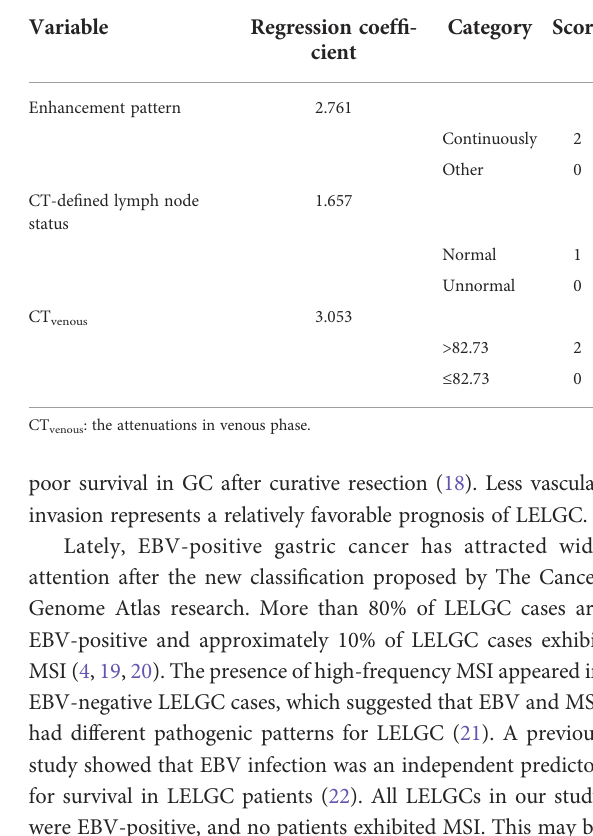
TABLE 4 The score for preoperative risk factors.